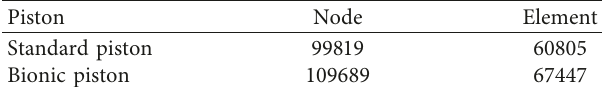
Figure 8: Piston grid division: (a) standard piston; (b) bionic piston. Table 3: Grid nodes and